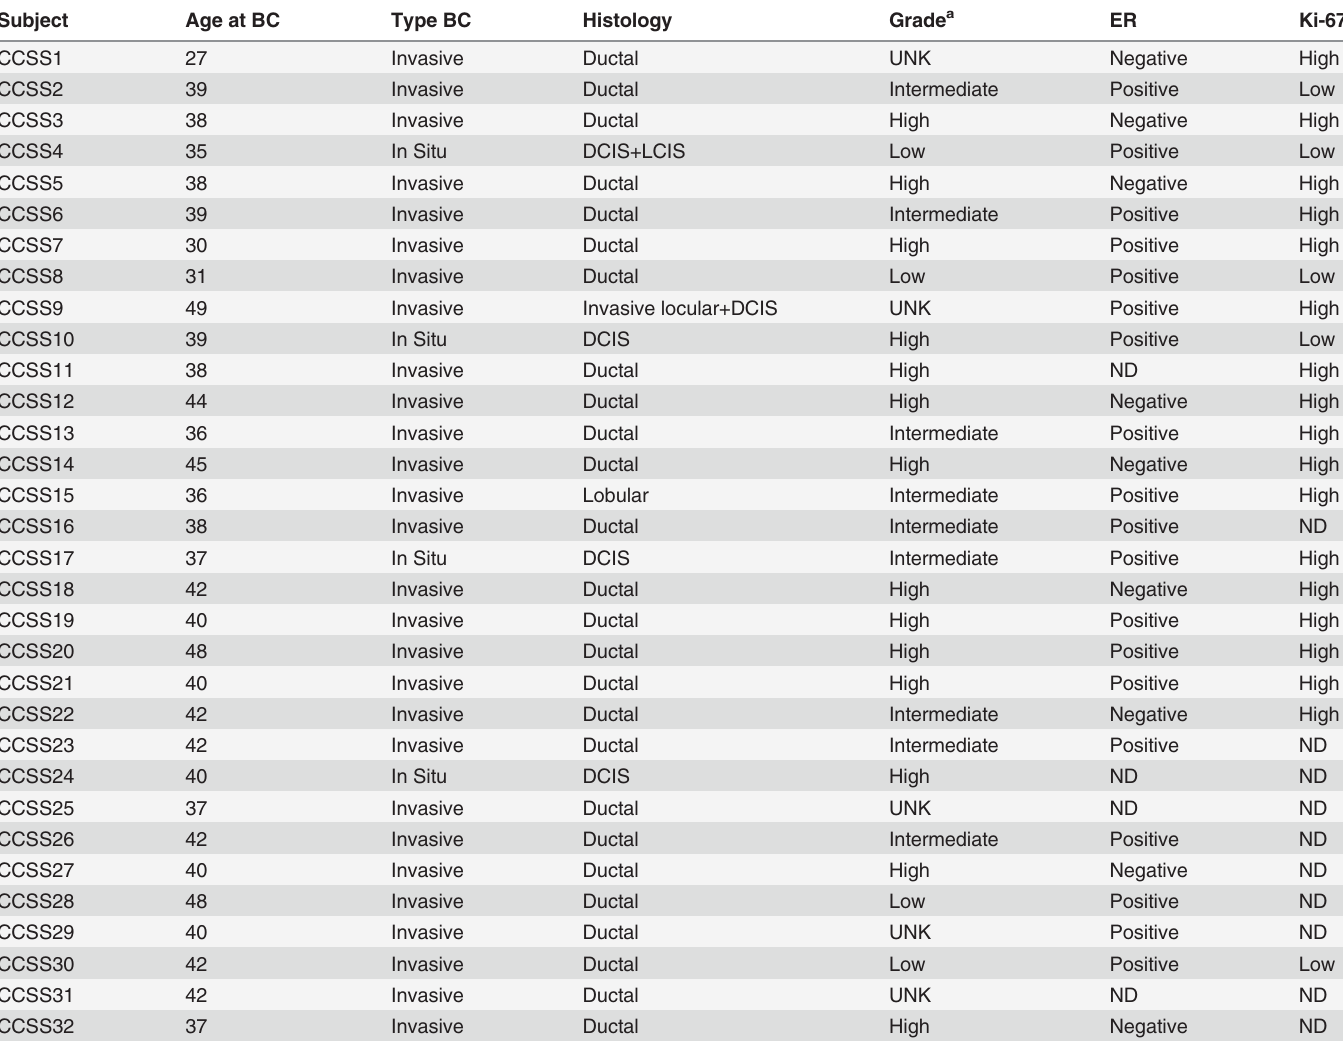
Table 2. Breast tumor characteristics of CCSS cases included in this study.